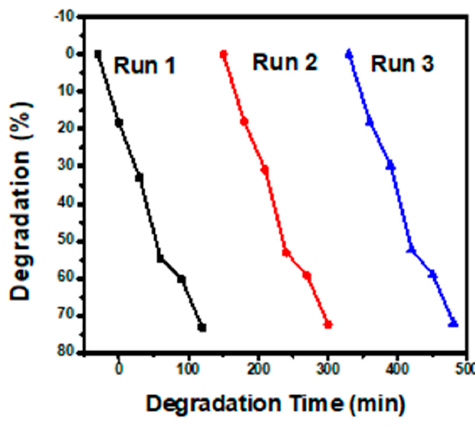
Figure 6. PL spectra of the photocatalysts.